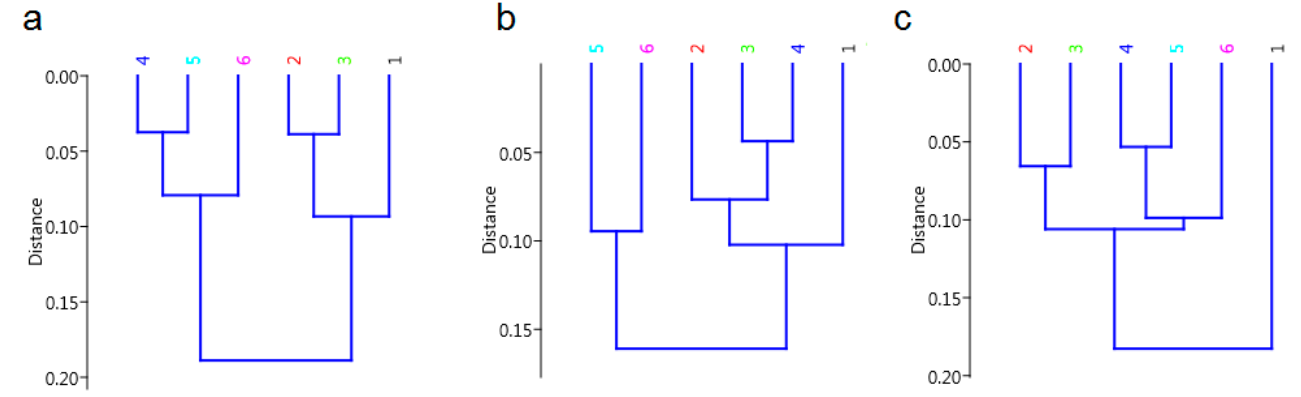
Figure 3. PCA analysis of FT-Raman spectra of wheat grains grown in 2017 ( a ), 2018 ( b ), 2019 ( c ); crop protection variants: (1) control (black dot); (2) intensive (red dot); (3) extensive (green dot); (4) PlanTonic BIO (blue dot); (5) PlanTonic BIO + Natural Crop (azure dot); (6) PlanTonic BIO + Biofol Plex (pink dot).